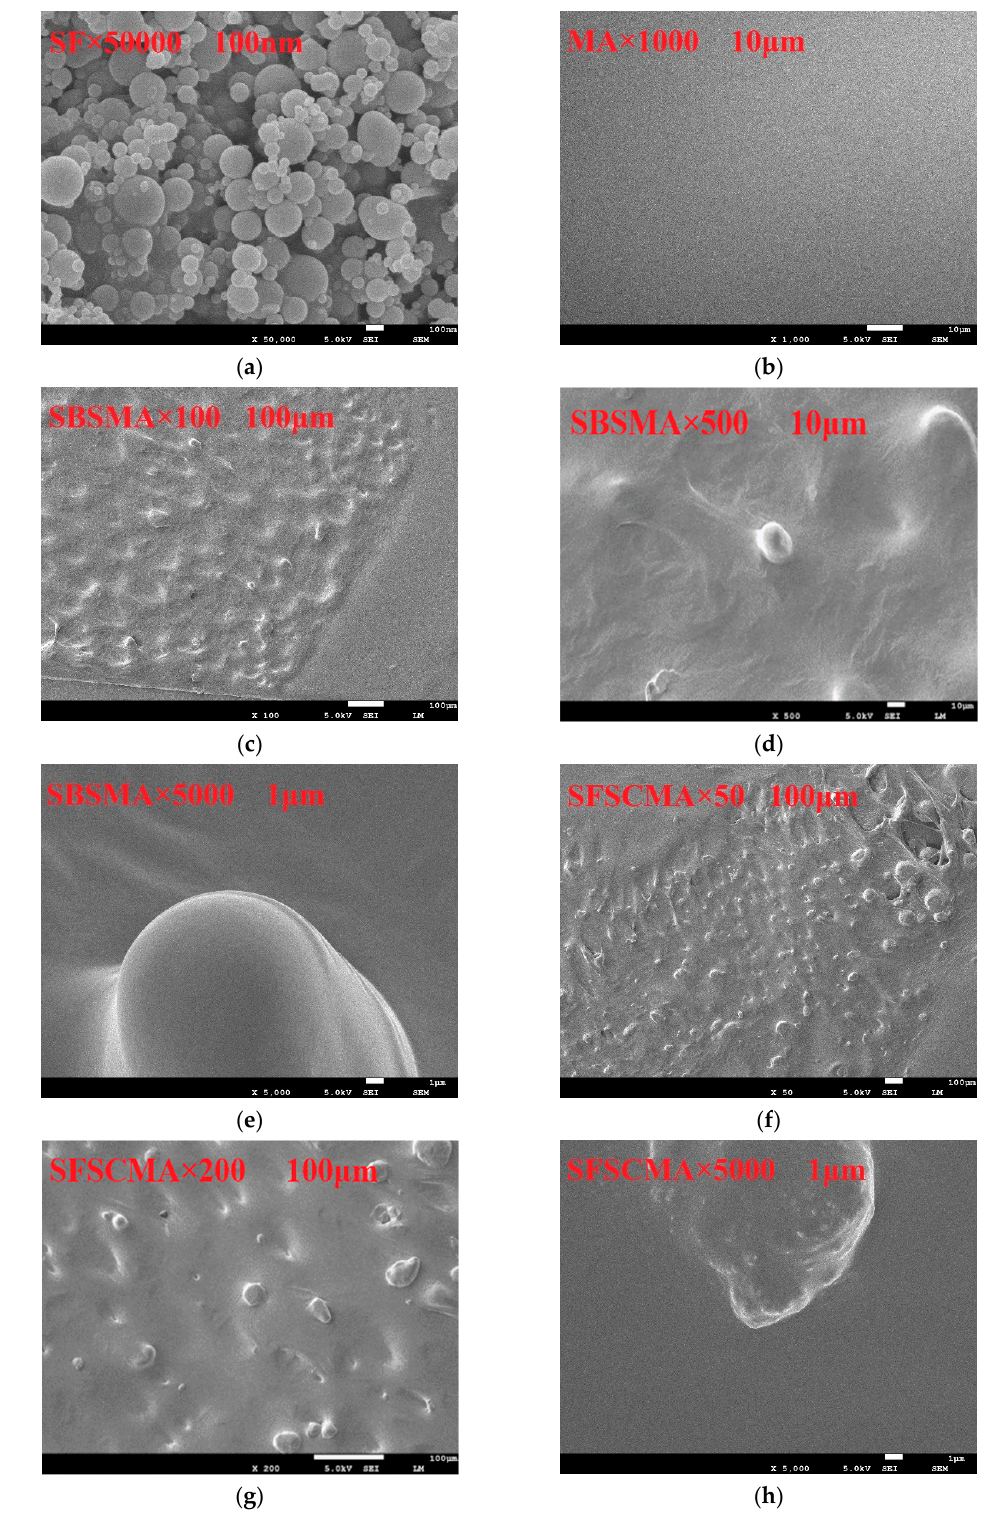
Figure 9. ( a ) SF 50000×; ( b ) MA 1000×; ( c ) SBSMA 100×; ( d ) SBSMA 500×; ( e ) SBSMA 5000×; ( f ) SFSCMA 50×; ( g ) SFSCMA 200×; ( h ) SFSCMA 5000×.